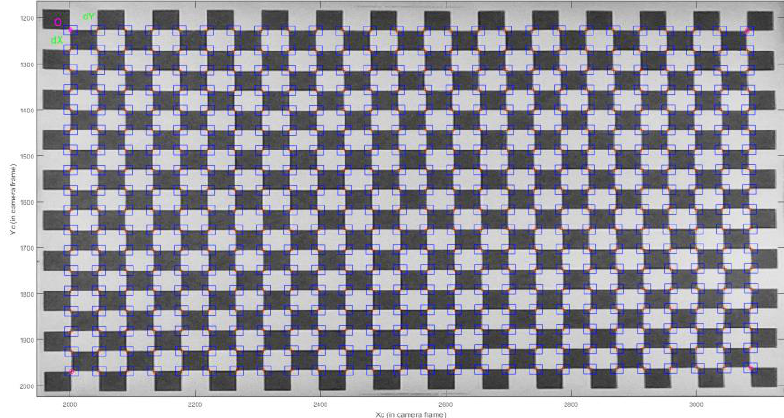
Figure 2. Chessboard test field Ground Control Point (GCP) detection in Matlab.